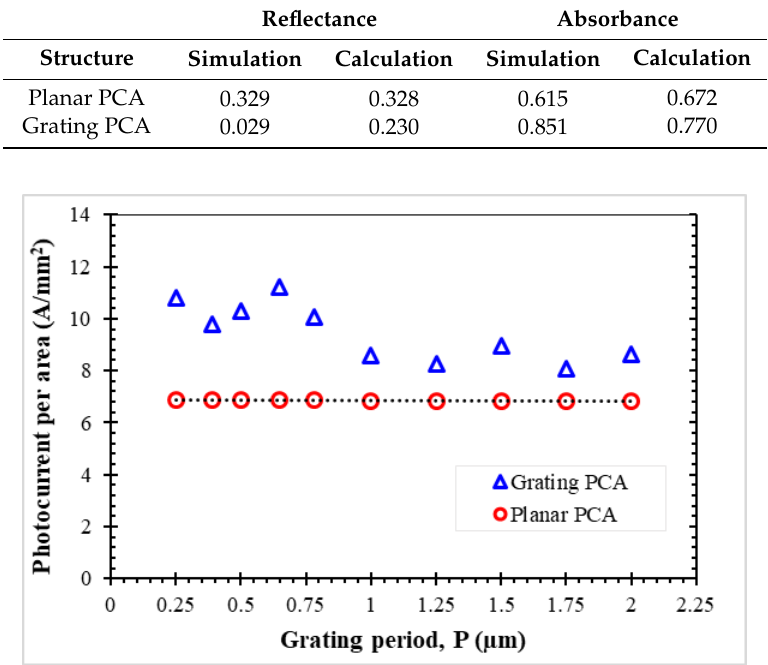
Figure 8. The simulated photocurrent in the planar PCA (red circle) and grating PCA (blue triangle) against grating period Λ . The planar PCA refers to F = 1 (done by setting W = Λ ). For the planar PCA, the induced photocurrent per illuminating area is almost constant.